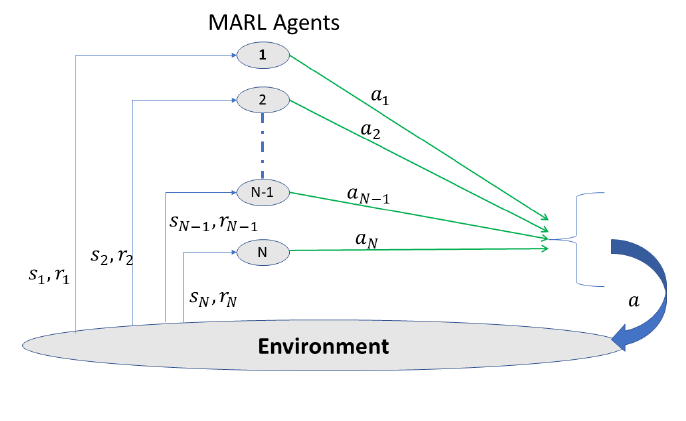
Figure 4. Multi-agent reinforcement learning